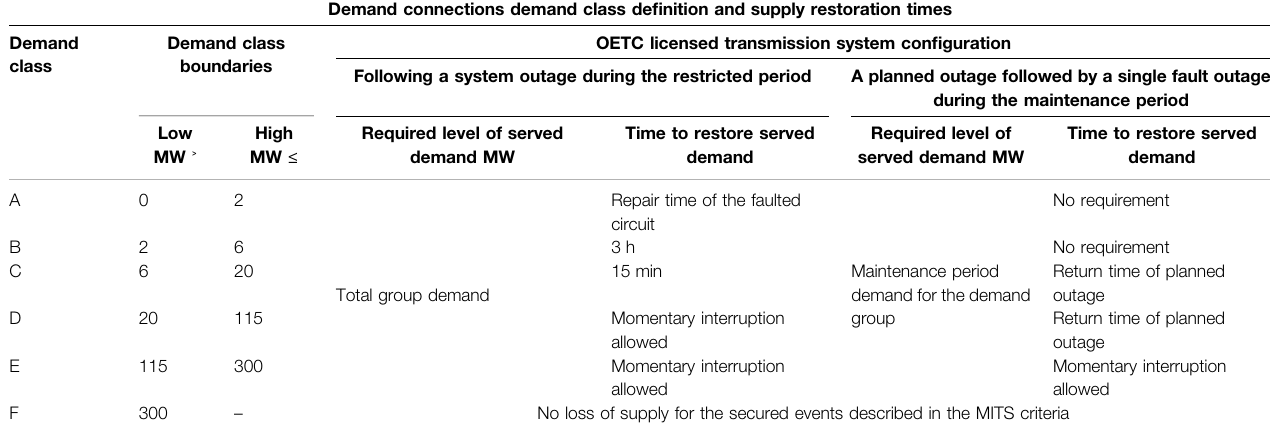
TABLE 2 | Demand connections – demand class speci fi